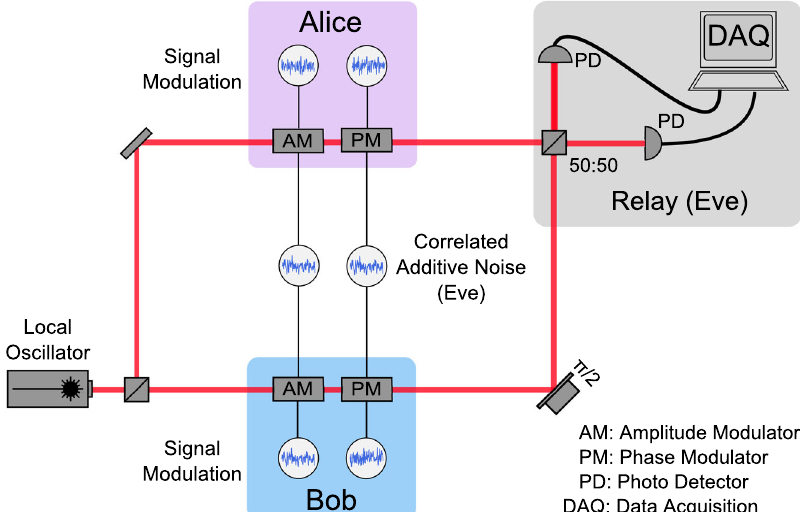
Fig. 6 Experimental setup. Alice and Bob receive 1064 nm light from the same laser source (local oscillator). At both stations, the incoming beams are Gaussianly modulated in phase and amplitude using electro-optical modulators driven by uncorrelated signal generators. In addition, the phase and amplitude modulators for Alice and Bob have correlated inputs respectively, such that a noisy modulation identical for both Alice and Bob is added to the phase and amplitude signals (side-channel attack). The magnitudes of the correlated noise modulations are progressively increased (from n = 0 to 4), and kept symmetrical between the quadratures, while the signal modulations are kept constant at the same level in both quadratures for Alice and Bob ( μ ≃ 52). At the untrusted relay, the modes are mixed at a balanced beam splitter and the output ports photo-detected, with an overall ef fi ciency of ≃ 98%. Photocurrents are then processed to realize a CV Bell measurement. See Supplementary Material for